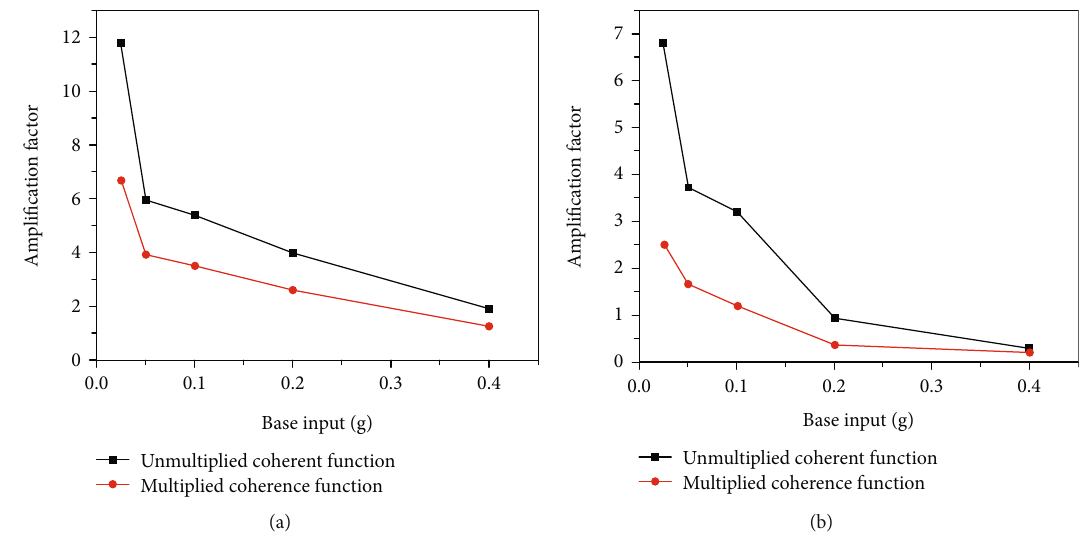
Figure 9: Ampli fi cation factor comparison chart of the unmultiplied coherent function and multiplied coherent function for di ff erent conditions (model 1 for the surface without water): (a) fi rs-order mode and (b) second-order mode.